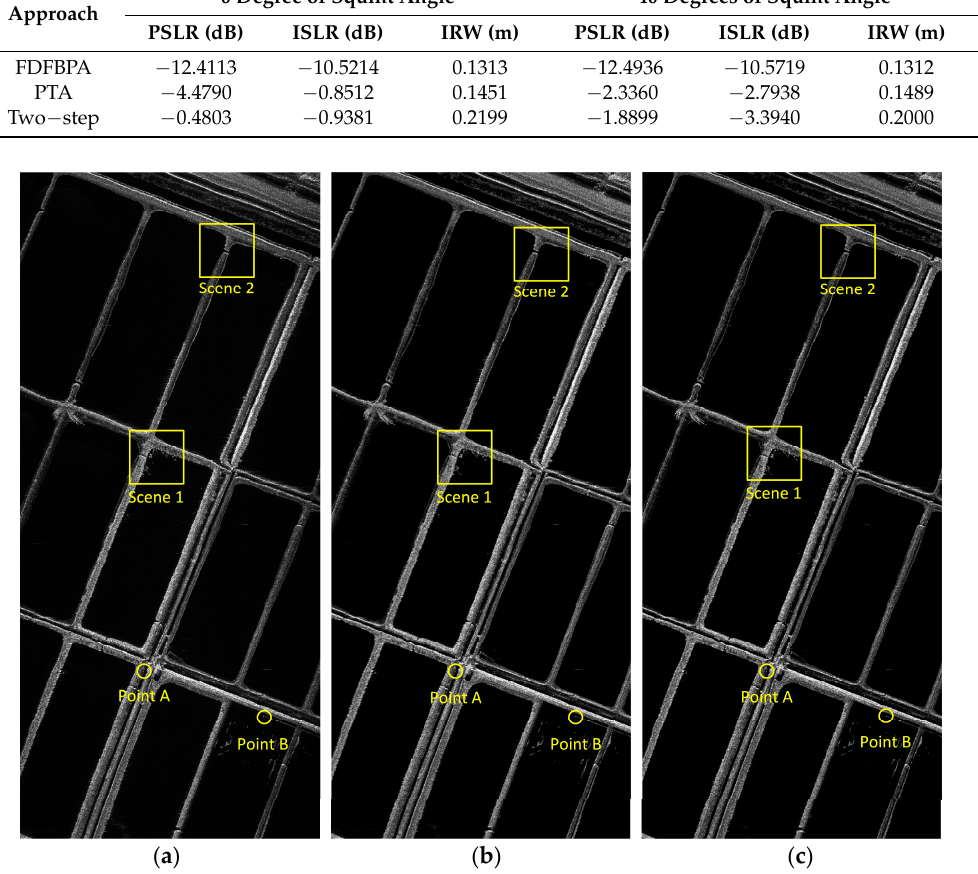
Figure 7. Imaging result processed with different algorithms: ( a ) FDFBPA; ( b ) PTA; ( c ) Two-step MOCO.